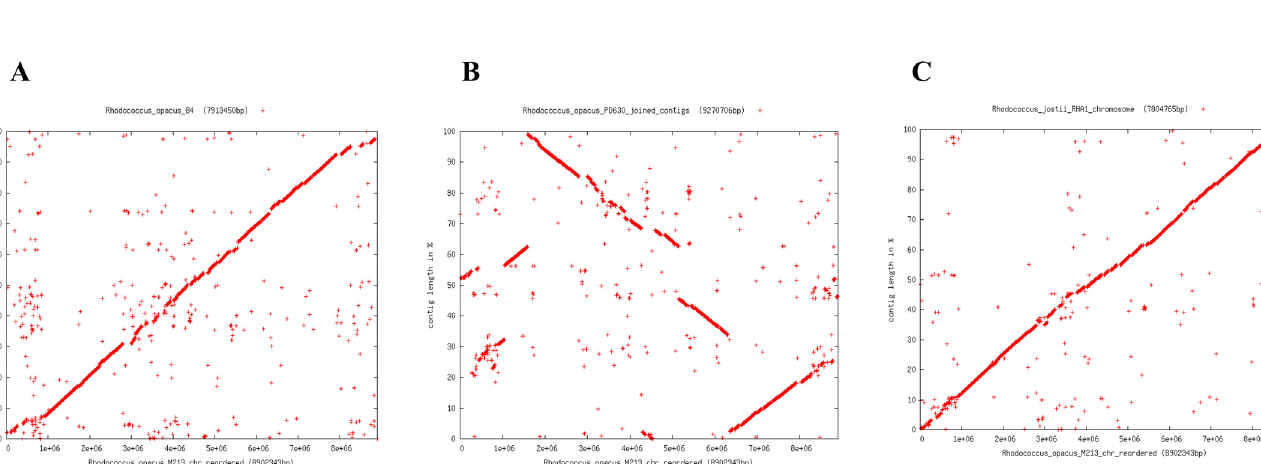
PLOS ONE | DOI:10.1371/journal.pone.0161032 August 17, 2016 10 /